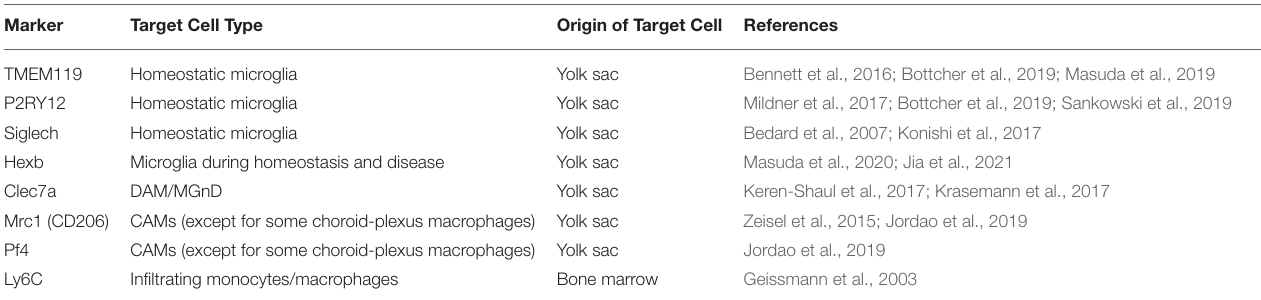
TABLE 1 | Markers of myeloid cells in the brain.